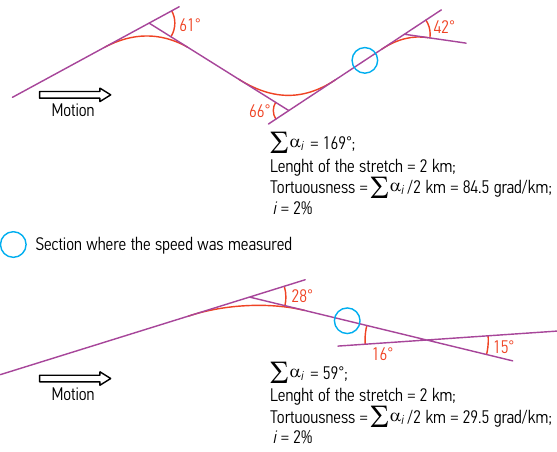
Fig. 2. Comparison between two different approaches to the section